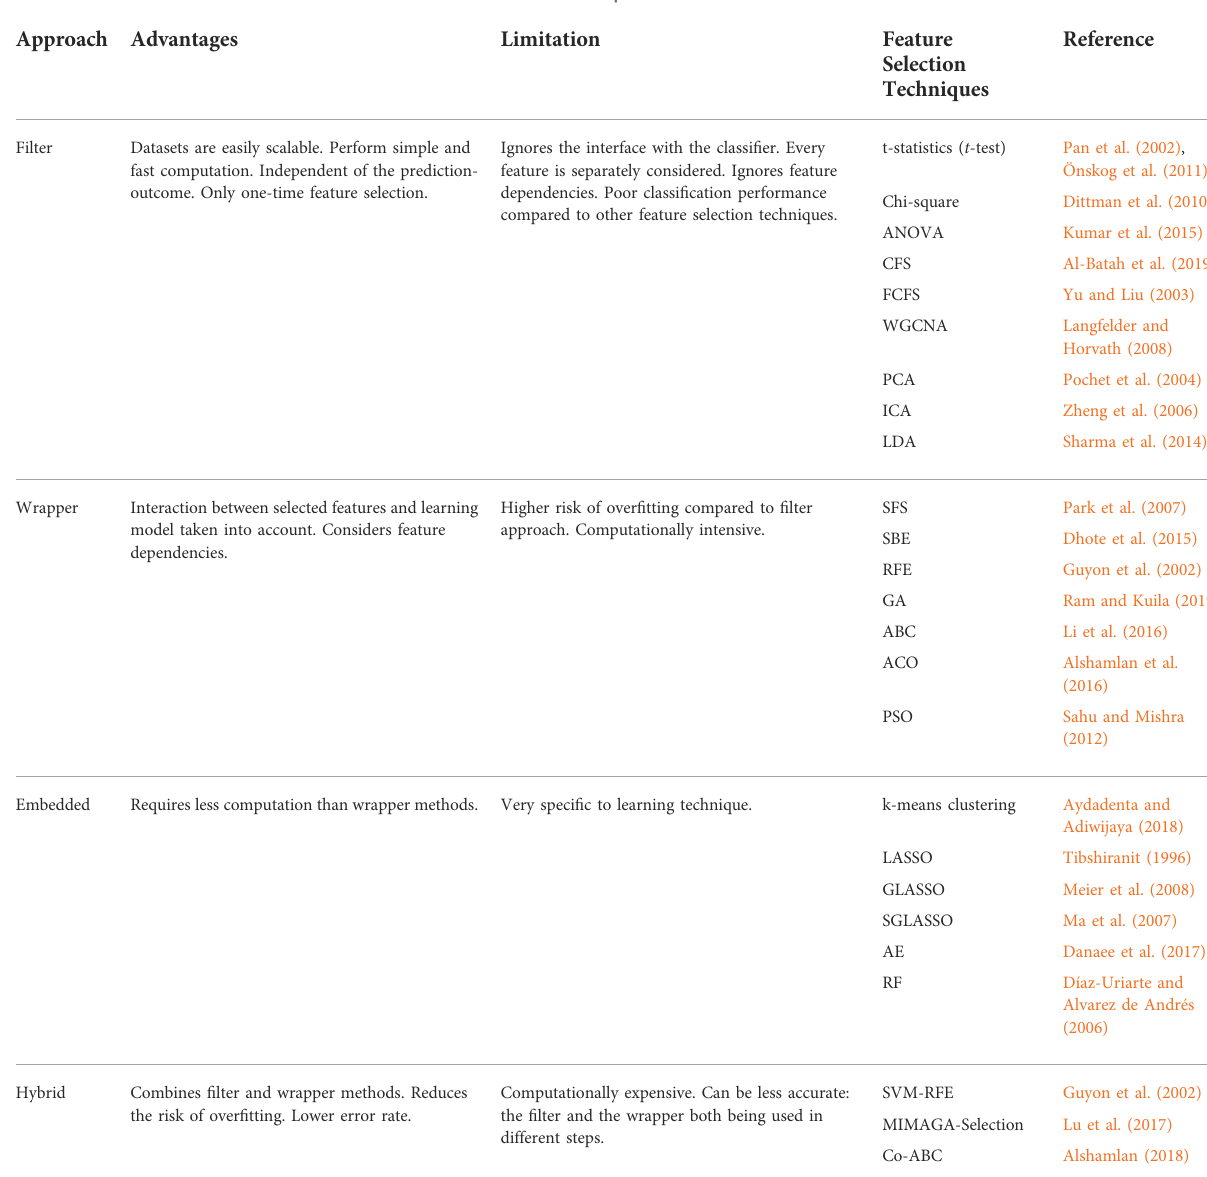
TABLE 4 List of different feature selection and feature extraction techniques. Approach Advantages